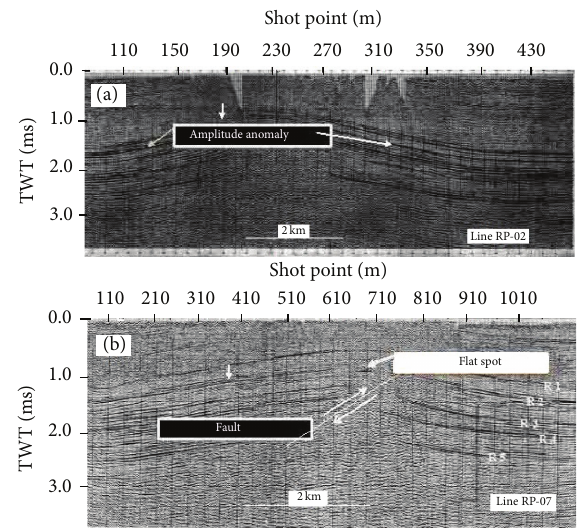
Figure 11: (a) Representation of amplitude anomaly along seismic line RP-02 of the Rashidpur structure. (b) shows presence of fault and flat spot along seismic line RP-07 of the Rashidpur